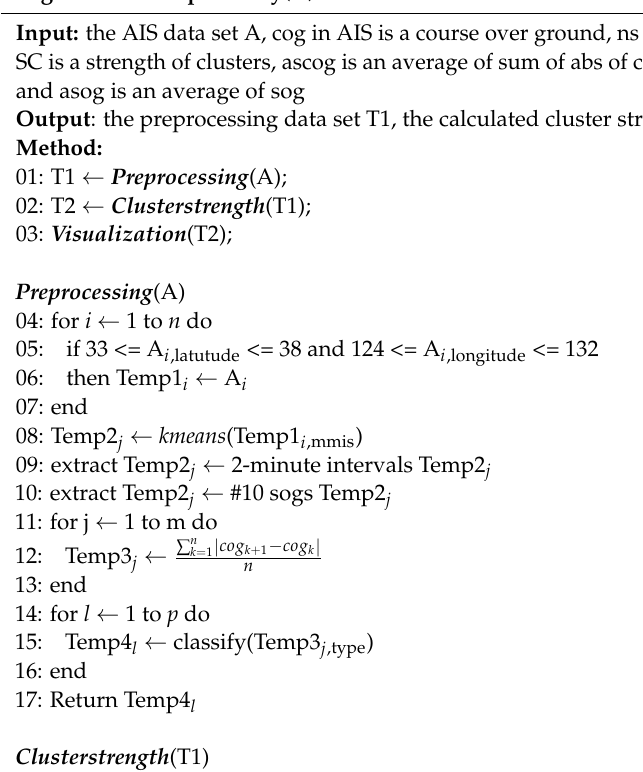
Figure 12. Visualization result of ship’s activity intensity on Google Earth. The Algorithm 1 for identification of distribution of ship types is as follows. Algorithm 1. ShipActivity( A )